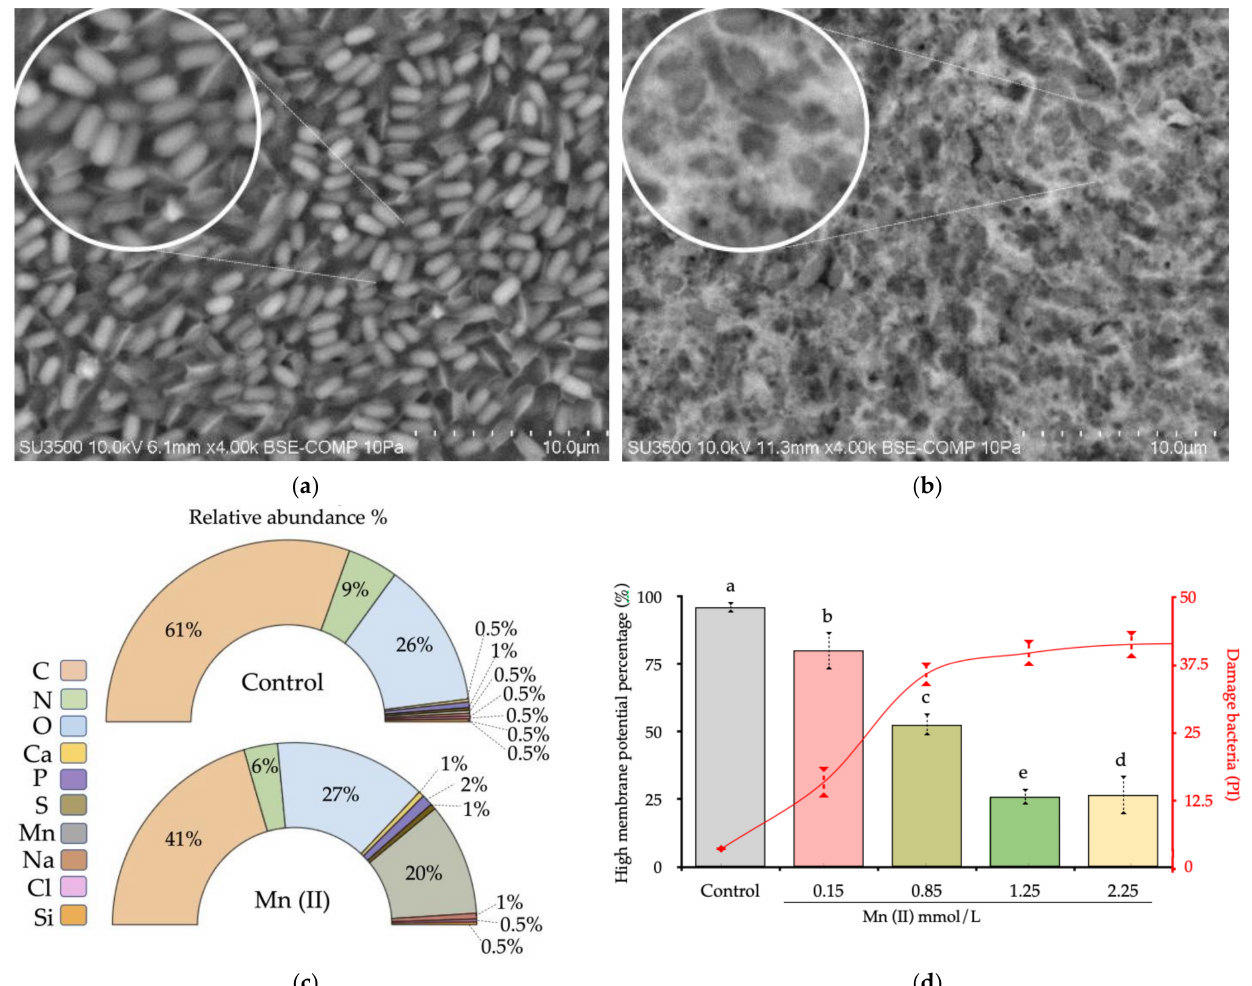
Figure 6. Morpho-physiological structure and membrane potential of A. oxydans after Mn(II) treatment. ( a ) Control. ( b ) Mn(II). ( c ) SEM-EDX analysis and comparison of detected elements between treatments. ( d ) Membrane potential by DiOc (6) fluorescence at increasing concentration of Mn(II) (each color bar) at 120 h of incubation at 30 ◦ C. Different letters show significant differences with p <